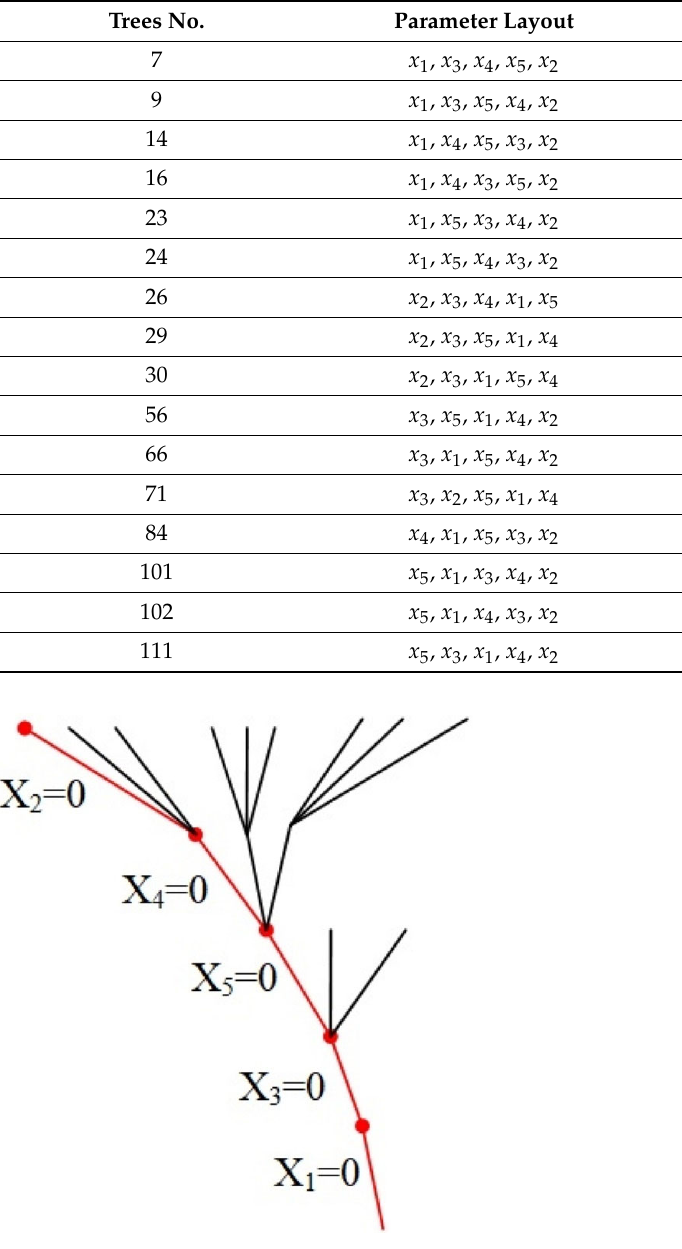
Figure 6. Realization stage of the optimal logic tree for X 1 = 0, X 3 = 0, X 5 = 0, X 4 = 0, and X 2 = 0.